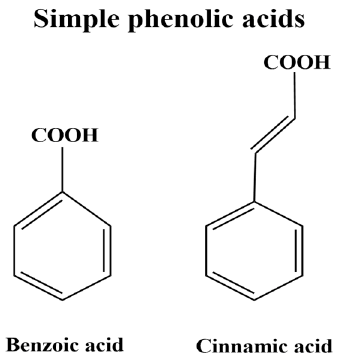
Figure 13. Simple phenolic